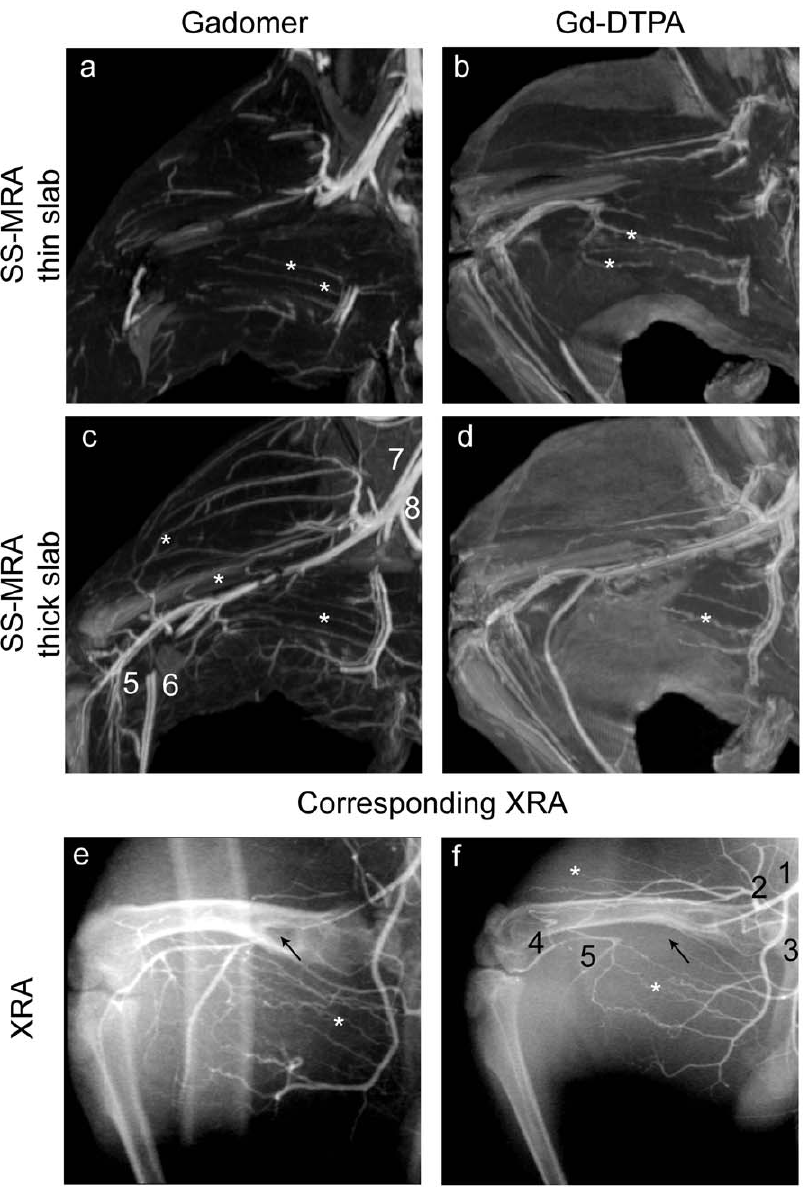
Figure 1. Contrast-enhanced MR angiograms with Gadomer and Gd-DTPA. Partial maximum intensity projections (MIPs) in the anterior- posterior direction of steady-state MR angiograms (SS-MRA) for Gadomer (left column) and Gd-DTPA (right column). On the thin-slab MIPs (thickness 3–4 slices, panels a and b), collaterals could be discerned for both contrast agents. Thick slab MIPs ( . 20 slices; panels c and d) show superior depiction of vessels with Gadomer. For Gd-DTPA, the images were blurred. Panels e and f show the corresponding x-ray angiograms (XRA). 1: femoral artery; 2: circumflex femoral artery; 3: deep femoral artery; 4: tibial artery; 5: popliteal artery; 6: popliteal vein; 7: iliac artery; 8: iliac vein. * indicate collaterals. The ligation is indicated with the arrow in the XRA images. All images were acquired on day